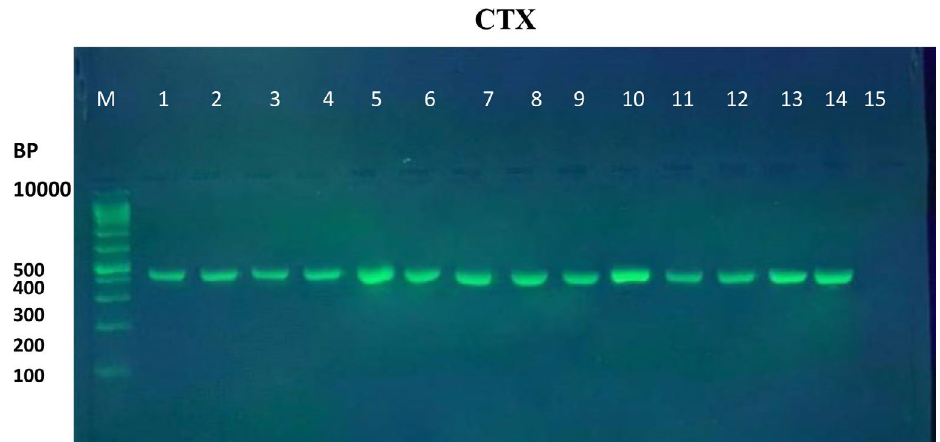
Fig. 1. Gel electrophoresis of PCR product of CTX-M gene in K. pneumoniae isolates, M= DNA molecular size markers (100 bp), 1 to 15 represents number of isolates, 1% agarose gel at 5 Vol /cm for 1:15 hours